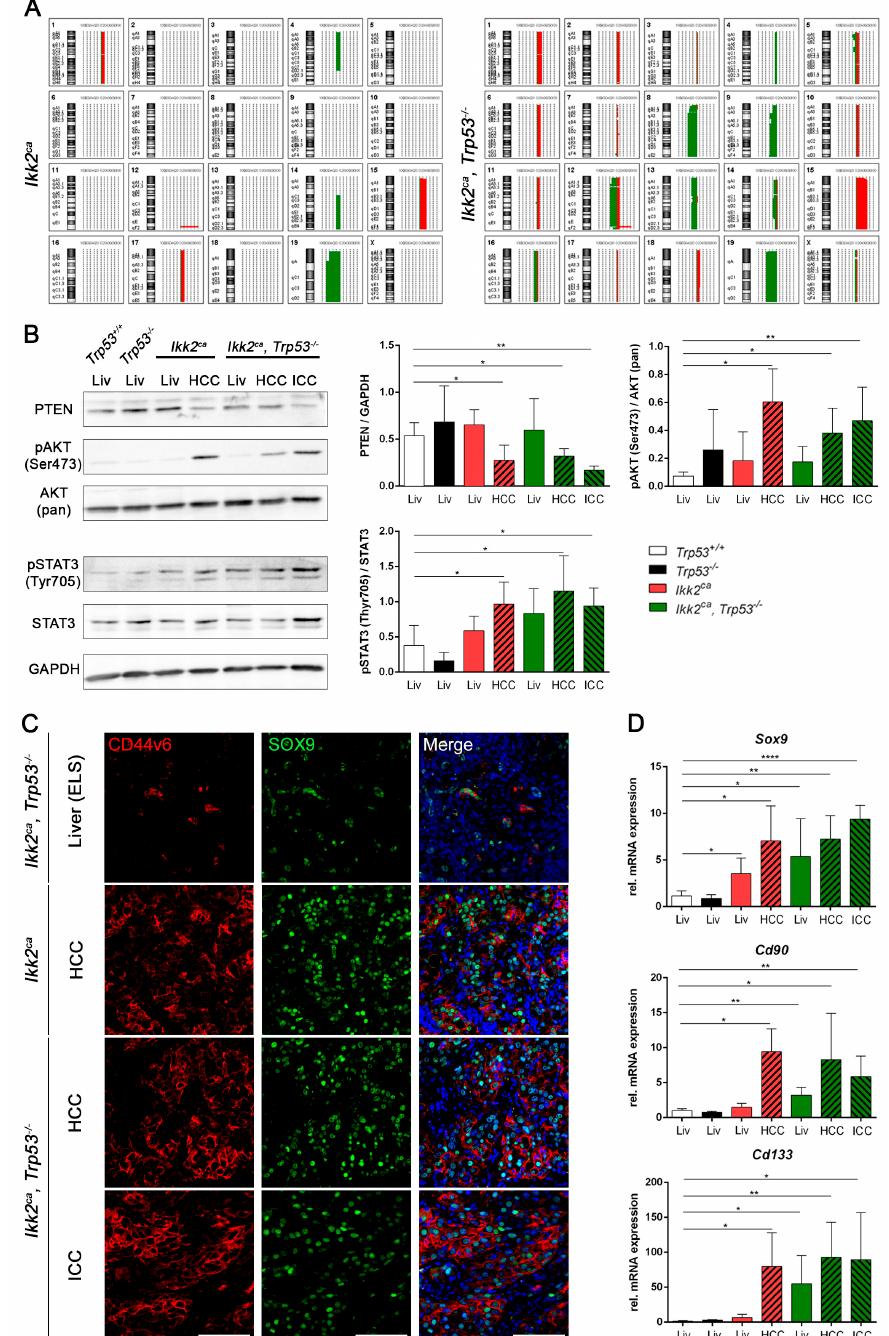
Figure 4. Ikk2 ca dependent activation of pAKT and pSTAT upon PTEN downregulation promotes the formation of progenitor-like cells. ( A ) Ideogram summarizes genomic imbalances (gains, red; losses, green) in tumors derived from Ikk2 ca ( n = 6) and Ikk2 ca Trp53 − / − ( n = 14) mice. ( B ) Representative Western blots of liver/tumor from 50 weeks old mice of the indicated genotype and bar graphs representing quantification of relative protein level of PTEN/GAPDH ( n = 4), pSTAT3/STAT3 ( n = 4) and pAKT/AKT ( n = 4). ( C ) Representative images of CD44v6 and SOX9-IF of liver (ELS—ectopic lymphoid structures) and liver carcinoma of Ikk2 ca , Ikk2 ca Trp53 − / − mice (scale bar: 100µm). ( D ) Bar graphs represent relative mRNA expression of the stemness markers Sox9 , Cd90 and Cd133 ( n = 3–5). Data represent the mean ± SD; * p < 0.05, ** p < 0.01, **** p < 0.0001.